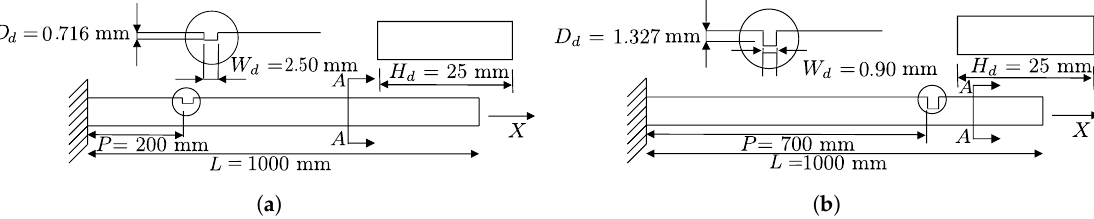
Figure 13. 2-D clamped free beam plan with rectangular geometry damaged case ( a ) and case ( b ). Table 5. Numerically measured natural frequencies of rectangular damaged case (a) and (b) with parameters of position and geometry size. Damaged